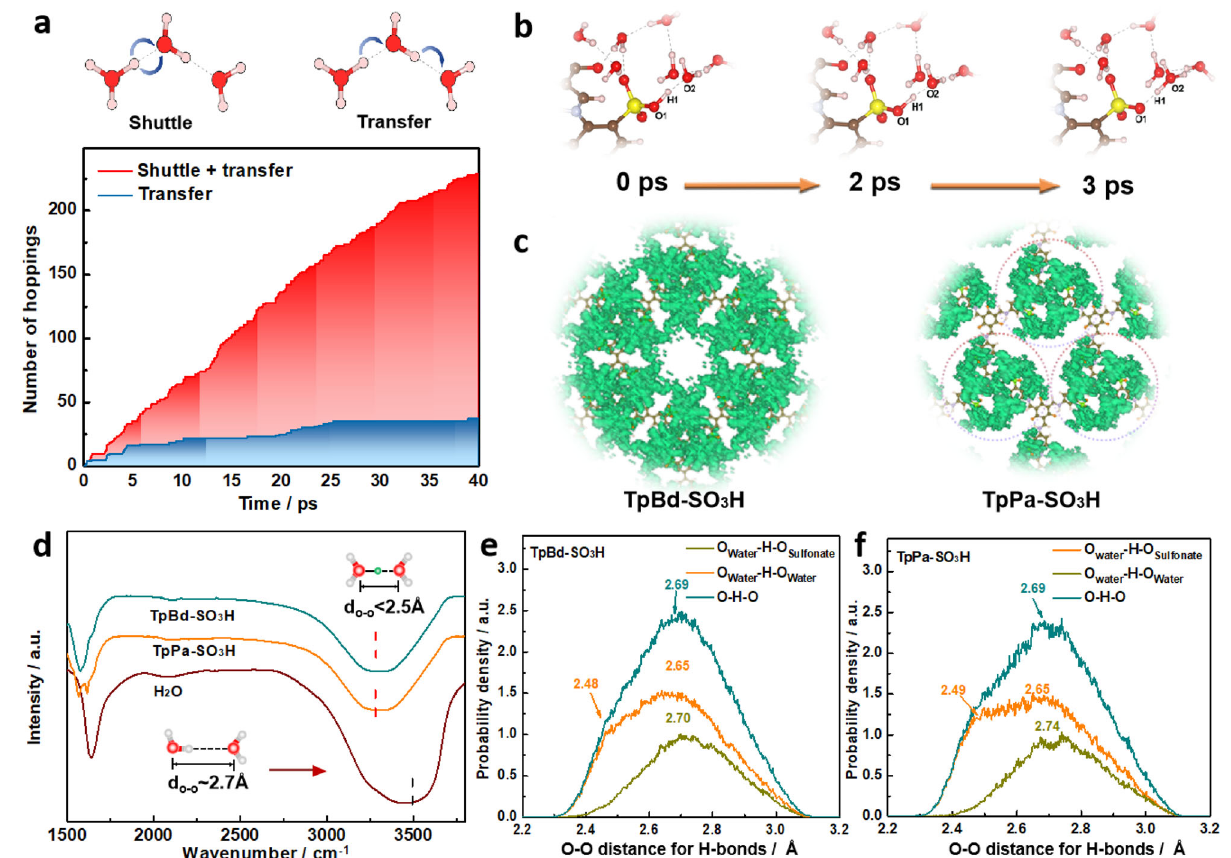
Fig. 4 | Proton transfer mechanism in iCOFMs. a Schematics of a shuttle event and a transfer event, and the number of proton hopping as a function of the simulation time. b Facile proton dissociation behavior. c The probability density